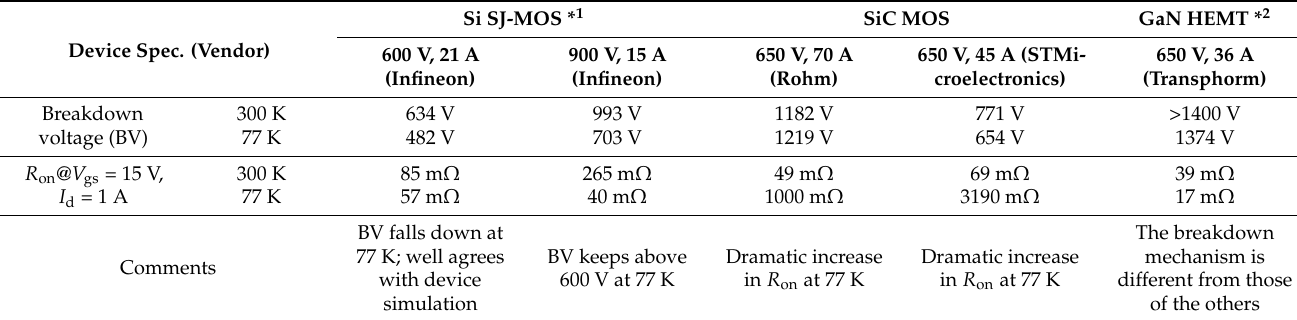
( b ) The electrolytic capacitor case